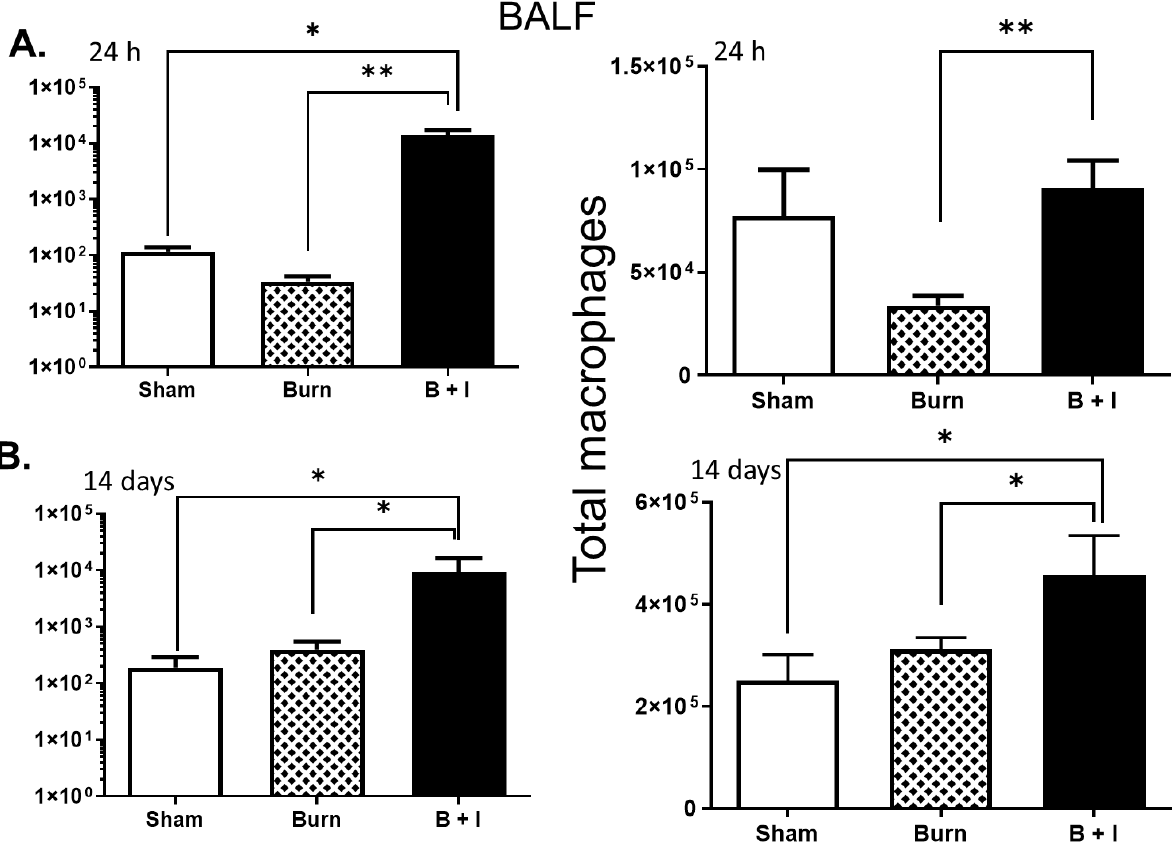
Figure 2. Innate immune cells are recruited to the airspace and to the pulmonary tissue in an injury- dependent manner early and late after injury. Mice underwent sham, burn, or combined injury, and cells isolated were examined for macrophage or neutrophil markers via flow cytometric analysis 24 h ( A ) or 14 days ( B ) after injury (n = 6 mice per group). Neutrophil (left panel) and macrophage (right panel) numbers were determined within the BALF by flow cytometry. In each case, data are presented +/ − SEM, with significance represented as * p < 0.05, ** p < 0.01. These data are representative of three independent experiments.